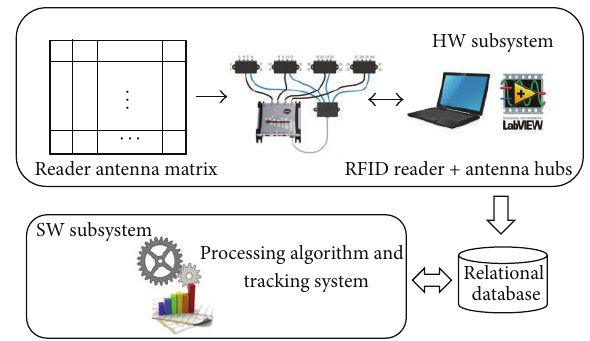
Figure 4: Overall schema of the proposed tracking